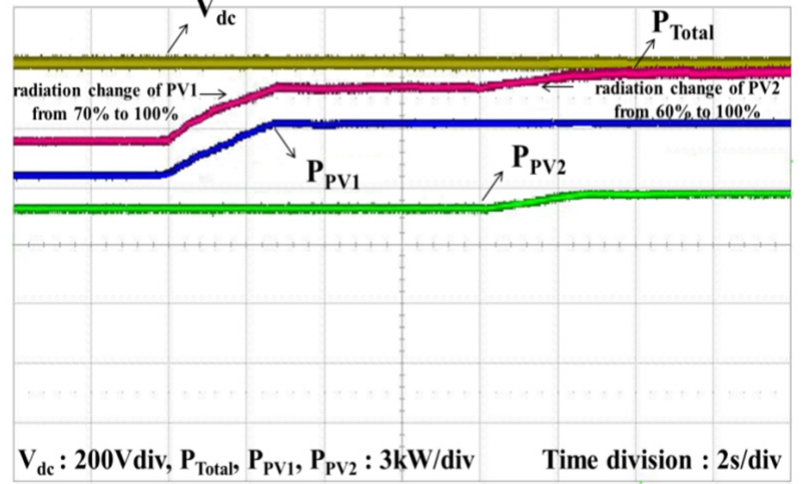
Figure 23. Experimental results for powers of inputs and output when the radiation of PV is